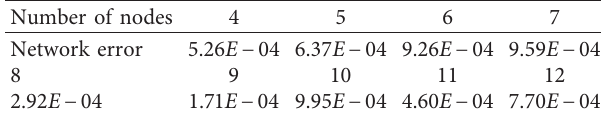
Table 7: Network errors of different hidden layer nodes.